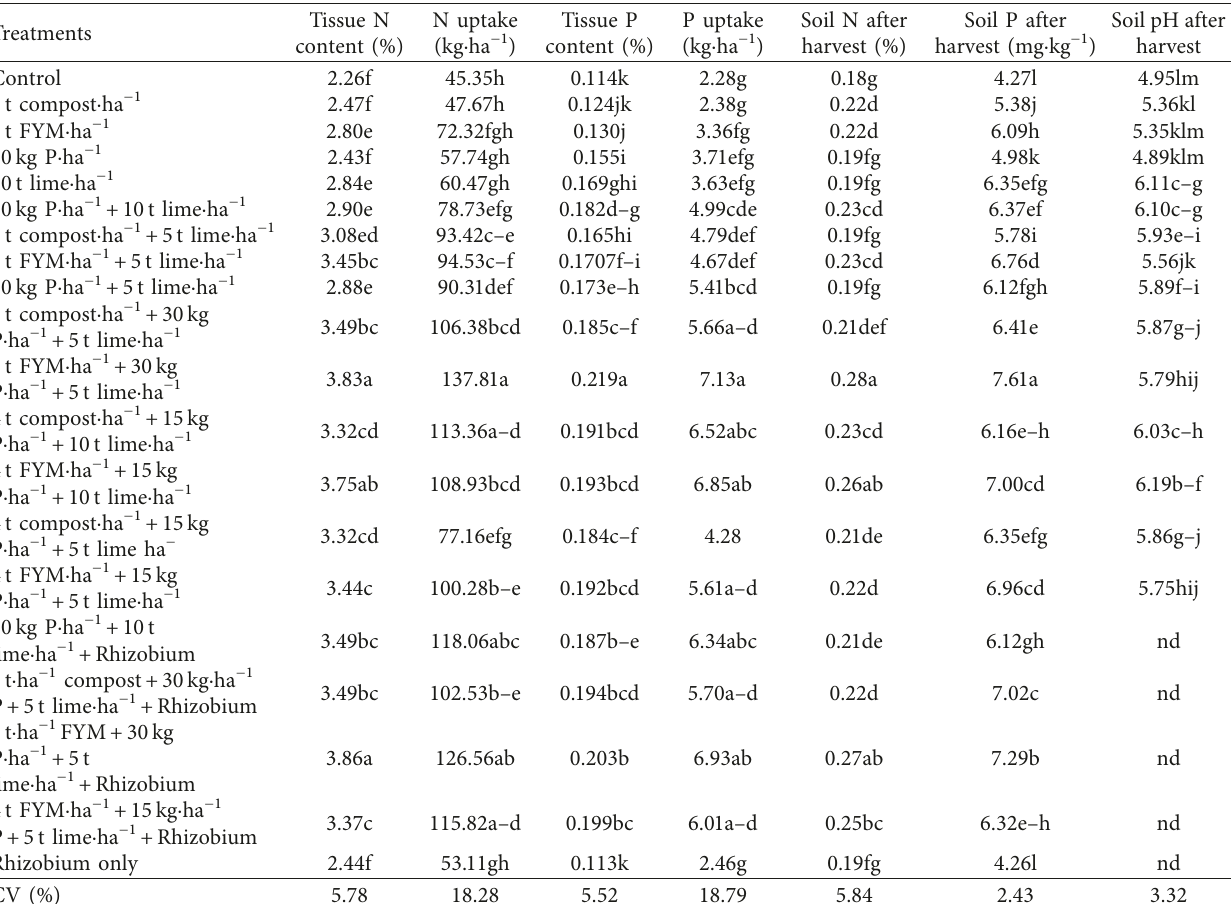
Table 3: Effects of organic and inorganic amendments on tissue N and P concentrations and uptakes and postharvest soil N and P.